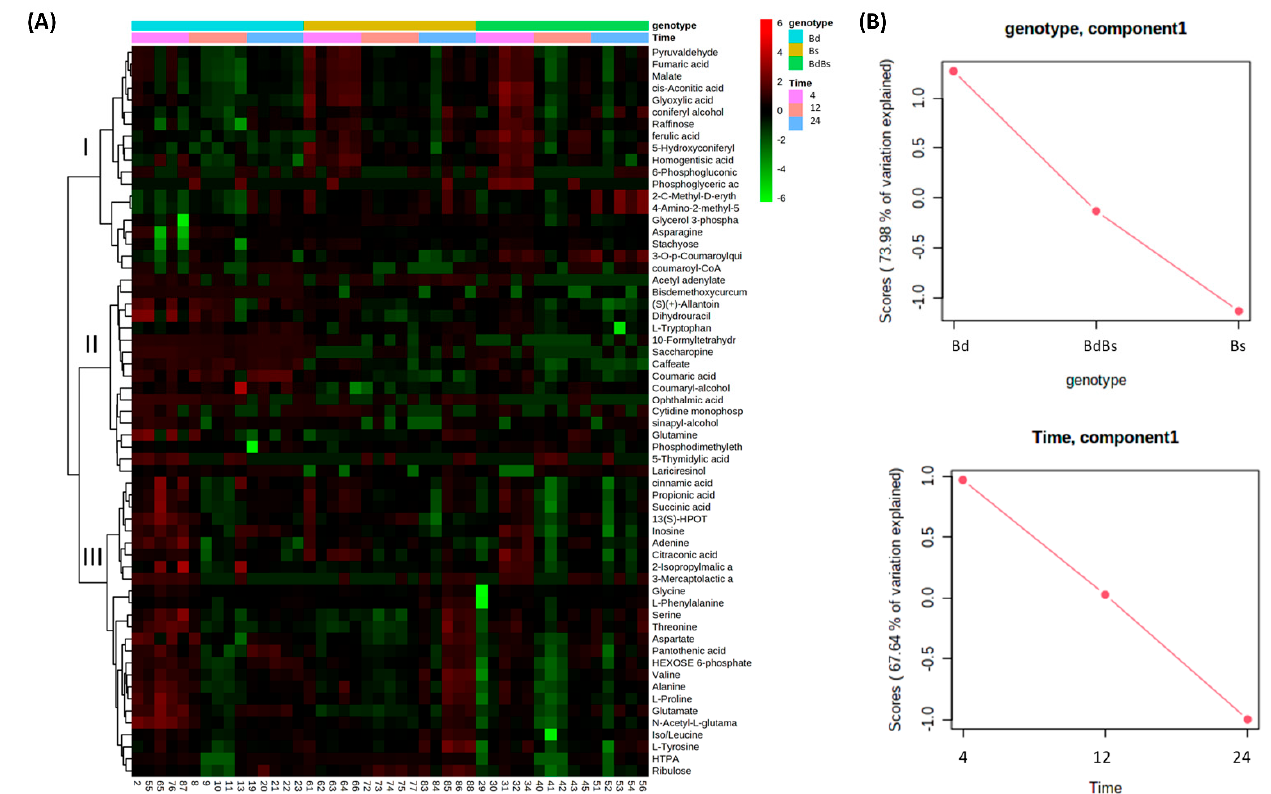
Figure 8. Metabolomic variation in Brachypodium endosperm during germination. ( A ) Heatmap of major sources of metabolite variation and ( B ) ANOVA–simultaneous component analysis showing effect estimates (genotype and time) in B. distachyon Bd21 (Bd), B. stacei ABR114 (Bs), and B. hybridum ABR113 (BdBs) at 4, 12, and 24 HAI.